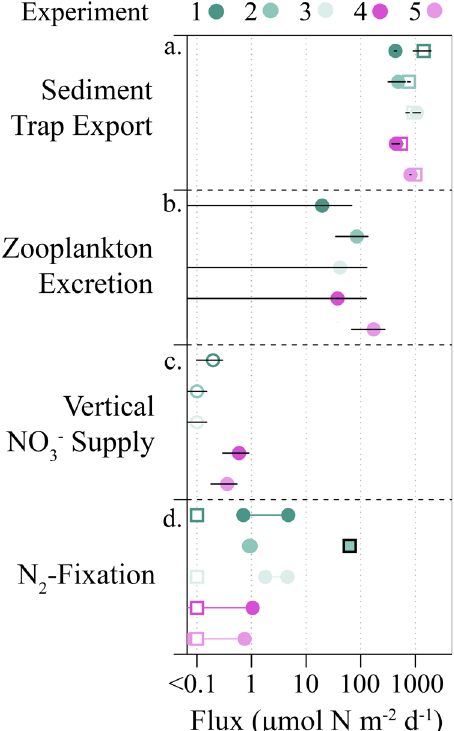
Fig. 2 Summary of observed euphotic zone nitrogen fl uxes from the oligotrophic Gulf of Mexico. a Sediment trap fl uxes include export at the base of the upper euphotic zone (UEZ) (open squares) and lower euphotic zone (LEZ; closed circles). b Zooplankton excretion below the euphotic zone. c Vertical mixing of nitrate into the LEZ. Mixing into UEZ not shown (~0). d N 2 - fi xation rates modeled from observed Trichodesmium biomass (UEZ; circles) and from δ 15 N-based budgets for the entire euphotic zone (squares) as reported in Knapp et al 15 . Fluxes < 0.1 µ mol N m − 2 d − 1 are shown on left as open symbols. Colors correspond to experiment as indicated with error bars indicating ± 1 SD of measurement means ( a – c ) or reported ranges ( d